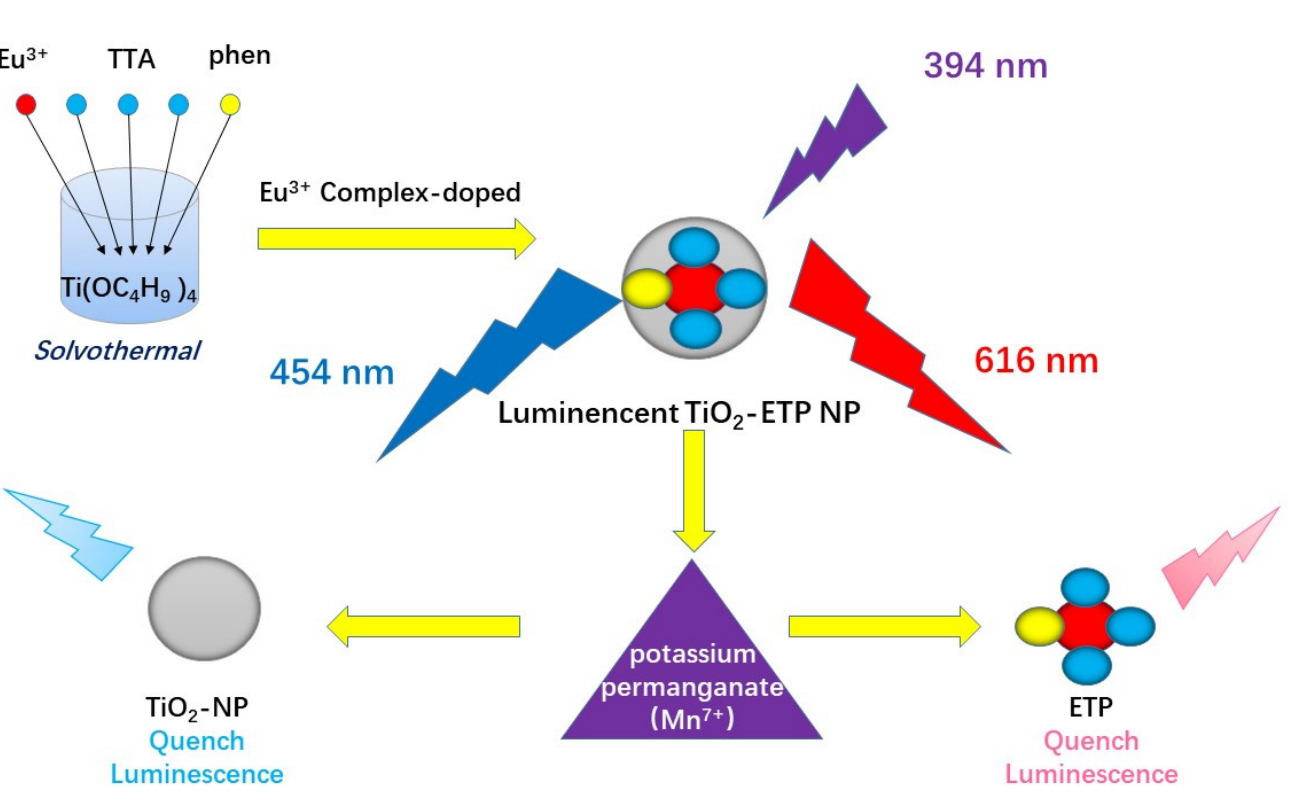
Figure 1. Schematic illustration of TiO 2 nanoparticles modified with Eu(TTA) 3 Phen preparation and sensing mechanism of manganese ion concentration.